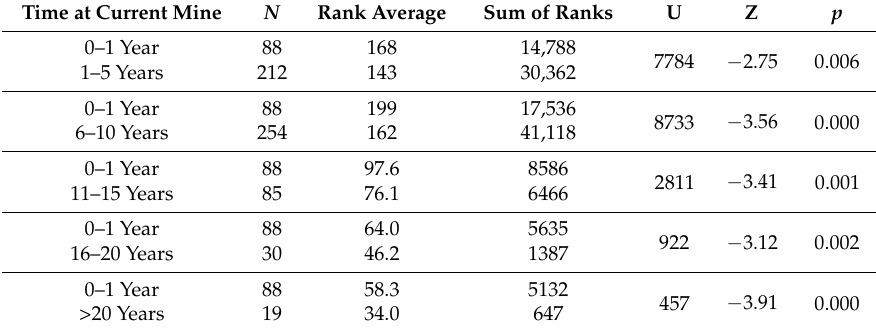
Table A2. Mann-Whitney results for mining experience groups and confidence in one’s ability to correctly explain or demonstrate “what to expect when wearing an